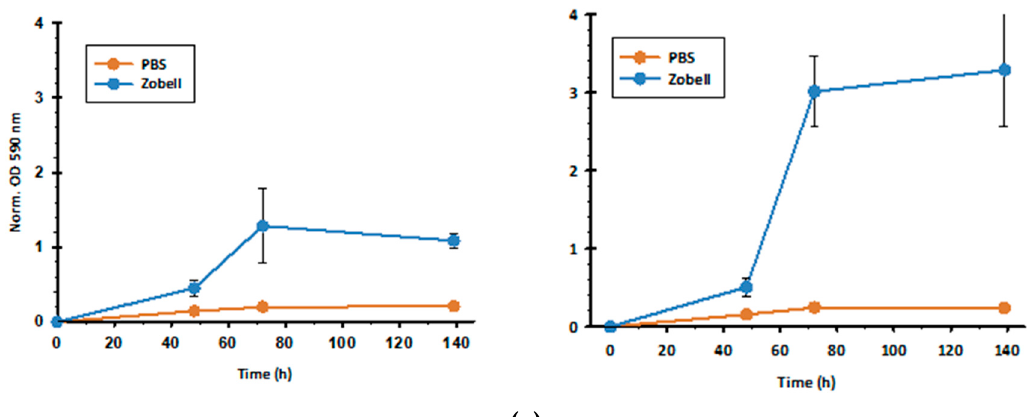
Figure 3. Evaluation of the biofilm formation by V. diabolicus and Vibrio sp. MS969. ( a ) Effect of the surface type at 20 and 30 °C in PBS; incubation was performed for 24 h. ( b ) Effect of the addition of glucose; biofilm was measured after 24 h and 48 h at 20 °C. ( c ) Kinetics of biofilm formation at 20°C in plastic tubes; cells were suspended in PBS or in Zobell. The OD of fixed crystal violet was normalized by dividing it per OD 600 nm.